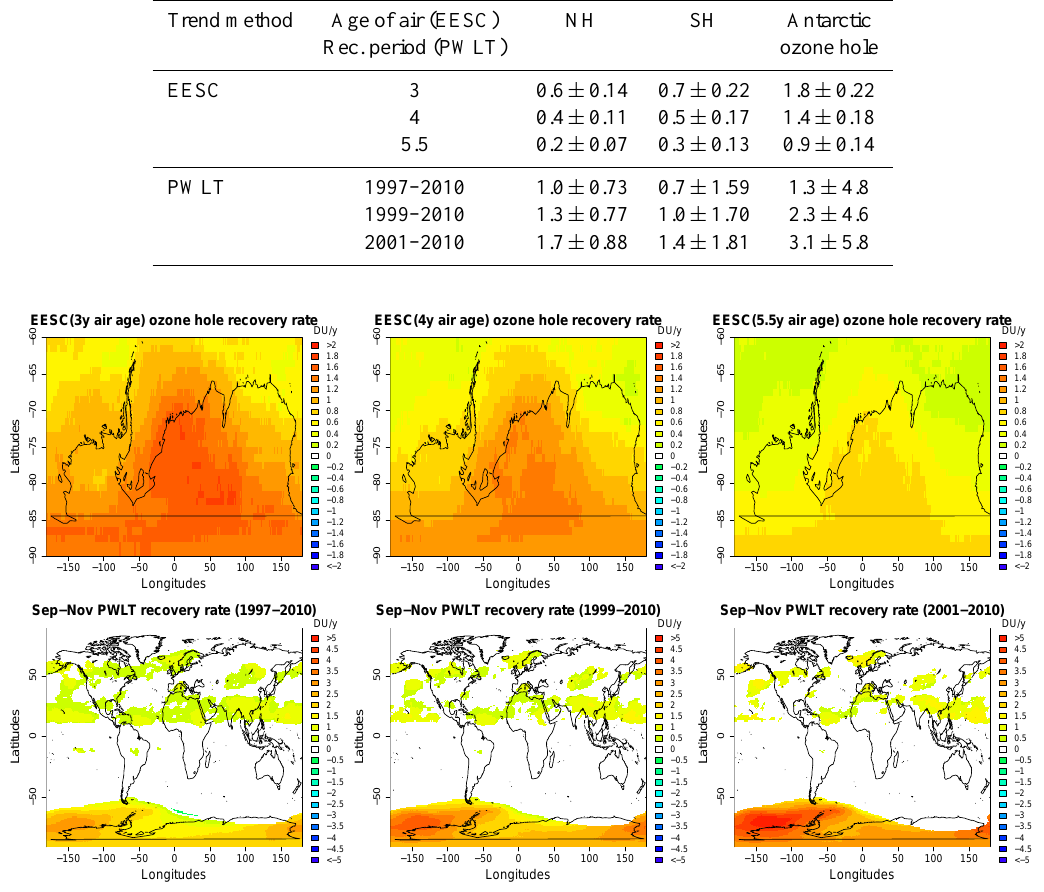
Figure 12. Ozone recovery rates based on EESC and EESC_2 regression estimates for the PHYS regressions south of 55 ◦ S (upper plots) and the straightforward piecewise linear regression estimates (lower plots) on ozone data averaged over September–November. Note that the color bar for the upper plots ranges from − 2 to 2DUyr − 1 , whereas for the lower plots the color bar ranges from − 5 to 5DUyr − 1 .